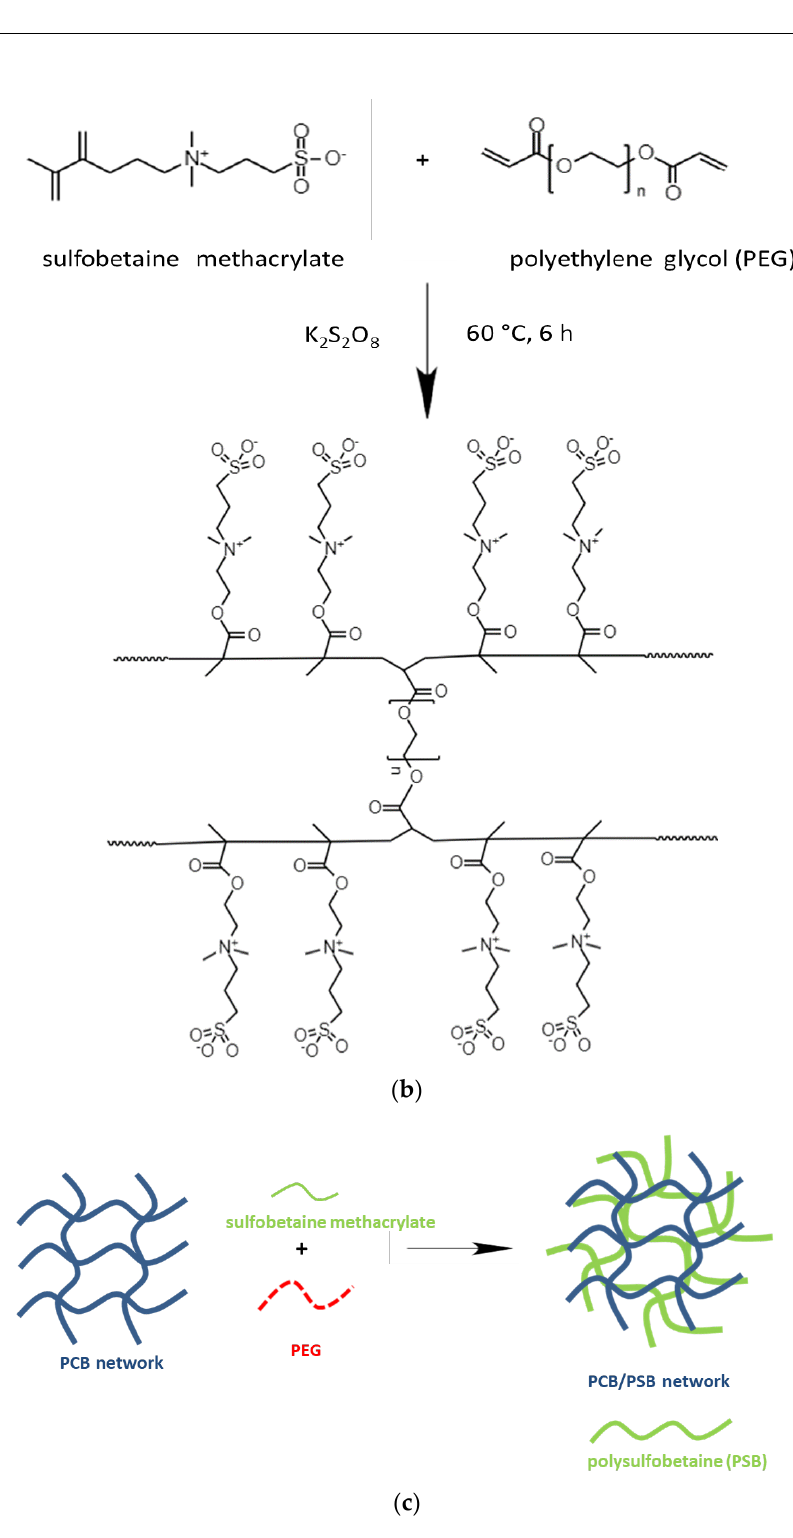
Scheme 3. Formation of PCB/PSB IPN by using the sequential method for IPN preparation: ( a ) PCB SN; ( b ) PSB SN and ( c ) sequential approach for PCB/PSB IPN